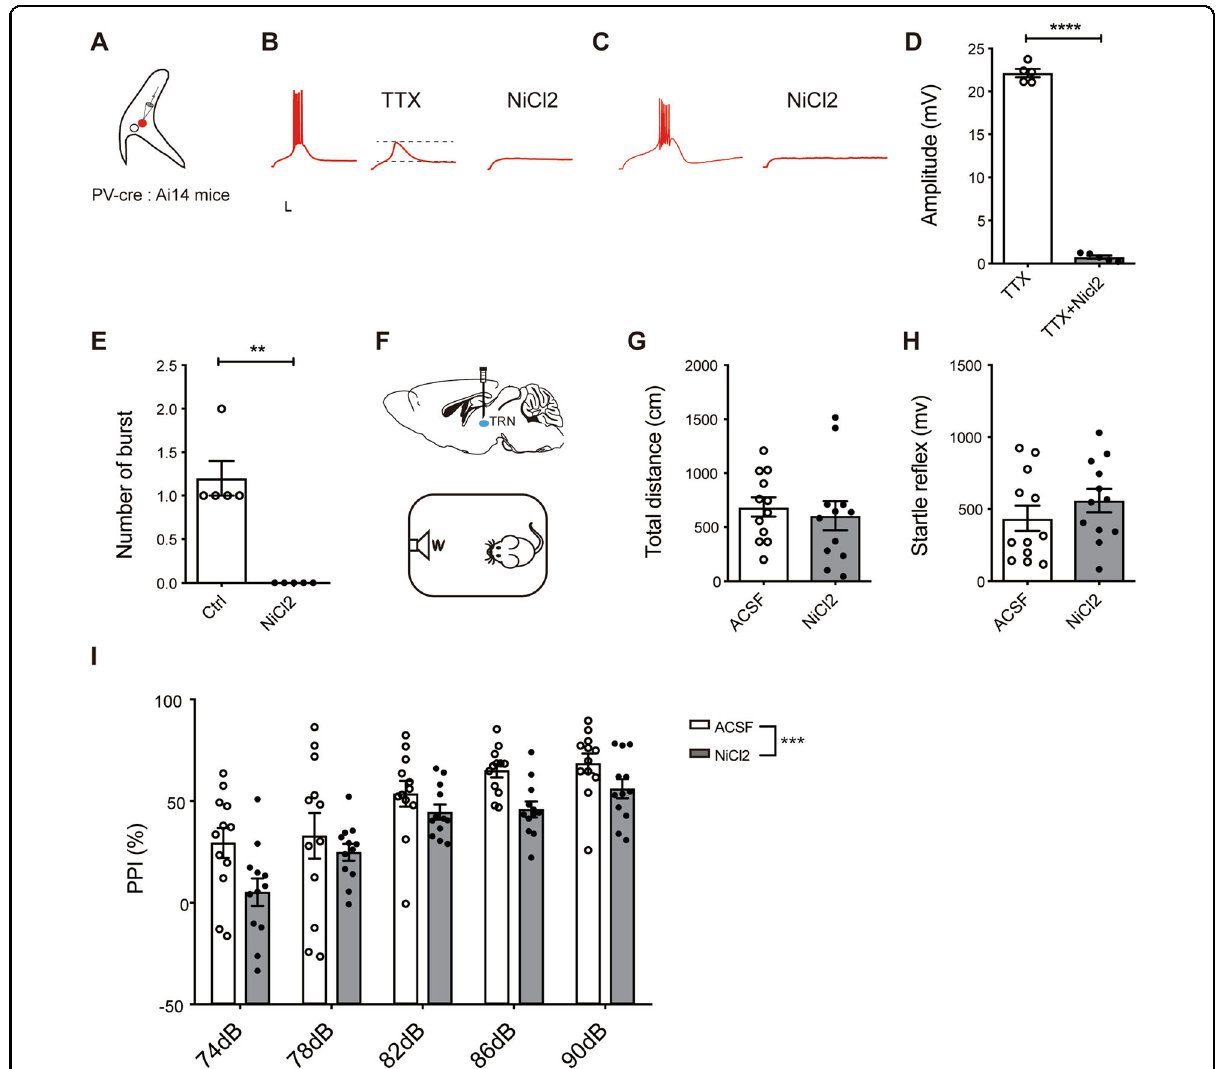
Fig. 4 NiCl2 causes blockage of burst fi ring of PV + neurons in audTRN and PPI performance impairment. A Electrophysiological recording in audTRN slice of PV-cre: Ai14 mice. B Left, example of burst fi ring induced by 60 pA inward current injection. Middle, action potential was blocked by 1 µM TTX. The spike between two dotted lines was T-type calcium channel spike, which was suppressed by 1 mM NiCl2 (right). Scale bars: 10 ms, 10 mV. C Burst fi ring was blocked by 1 mM NiCl2. D Quanti fi cation of the calcium spike amplitude from the TTX and TTX + NiCl2 group. NiCl2 blocked the calcium spike (paired two-tailed t -test, t 4 = 31.390, P < 0.0001, N = 5 cells). E Quanti fi cation of the burst number from the control and NiCl2 group. NiCl2 blocked burst fi ring completely (paired two-tailed t -test, t 4 = 6.000, P = 0.0039, N = 5 cells). F Schematic of pharmacological experiment. Cannulas were unilaterally implanted into audTRN of C57 mice. After 7 days recovery, mice were given 6 mM NiCl2 or ACSF 30 min before OFT and PPI paradigm. G , H Infusion of 6 mM NiCl2 into audTRN of mice had no effect on total distance in OFT (Student ’ s t -test, t 22 = 0.5074, P = 0.6169, N = 12 mice per group) or startle re fl ex in PPI (Student ’ s t -test, t 22 = 1.027, P = 0.3158, N = 12 mice per group). I Infusion of 6 mM NiCl2 into audTRN of mice impaired PPI performance (two-way ANOVA, F (1,110) = 14.480, P = 0.0002, N = 12 mice per group). ** P < 0.01, *** P < 0.001, **** P <